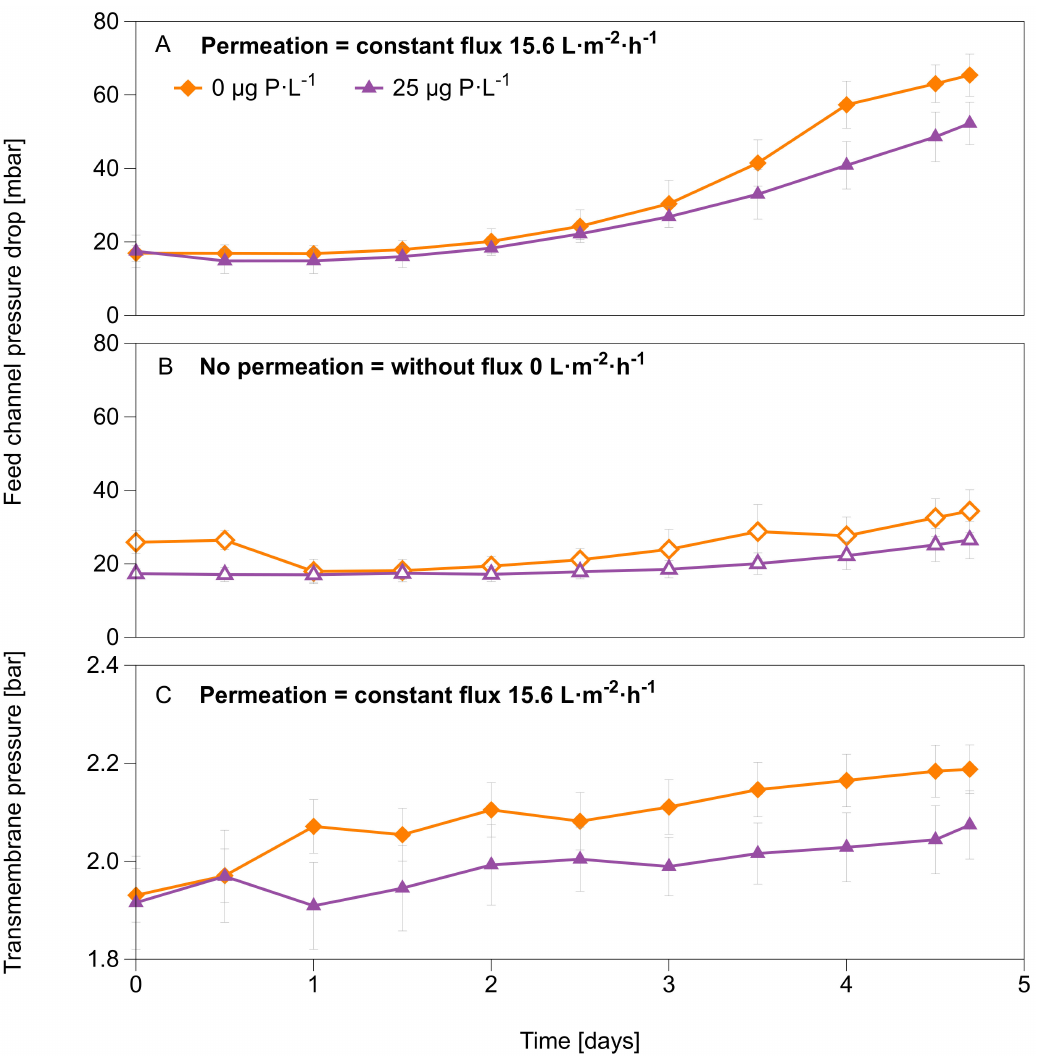
Figure 3. Membrane fouling simulator (MFSs) performance parameters over 4.7 days of MFSs operation. Feed channel pressure drop over time for the MFSs run under ( A ) permeation conditions at a constant flux of 15.6 L · m 2 · h − 1 , and ( B ) without permeation. ( C ) Transmembrane pressure over time for the MFSs run under permeation conditions at a constant flux of 15.6 L · m 2 · h − 1 , with varying dosed phosphorus concentrations (0 and 25 µ g P · L − 1 ) and a dosed assimilable organic carbon concentration of 250 µ g C · L − 1 in the feed water. The error bars represent the data of independent triplicate MFS